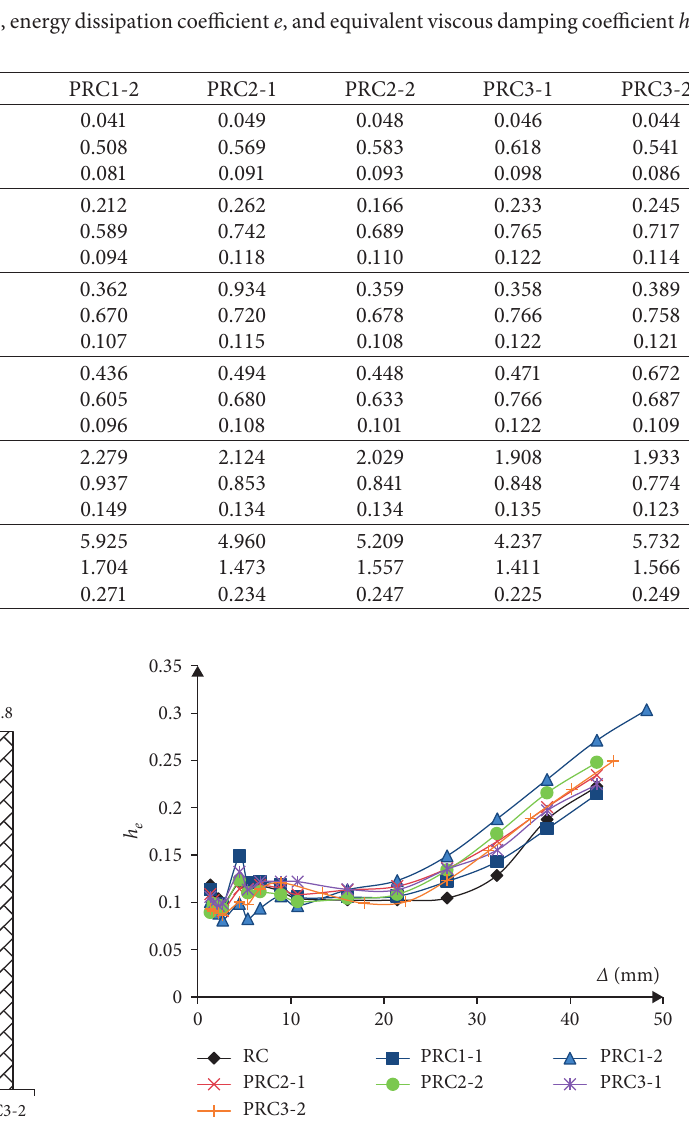
Figure 12: Equivalent viscous damping coefficient displacement ( h e - Δ )